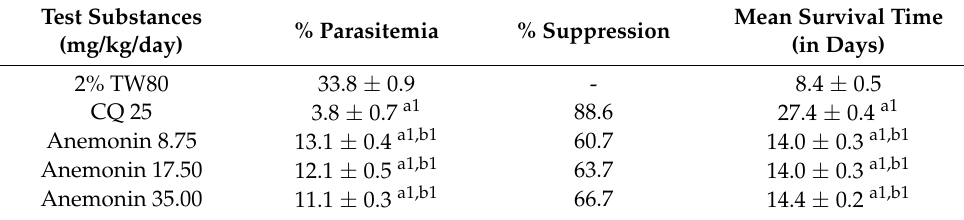
Table 8. Prophylactic antimalarial activity of anemonin in Plasmodium berghei -infected